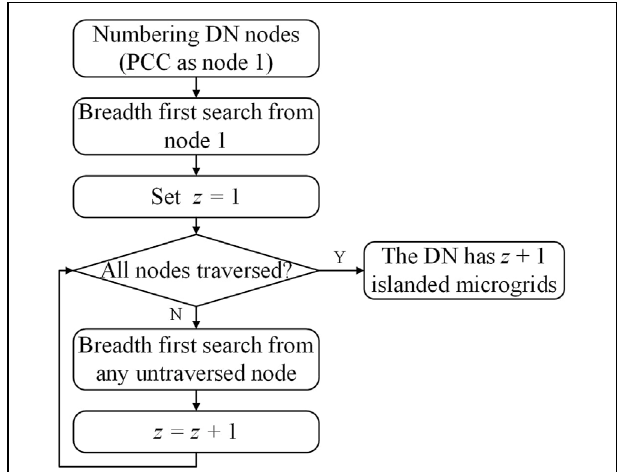
FIGURE 4 | Flowchart of DN islanding microgrid